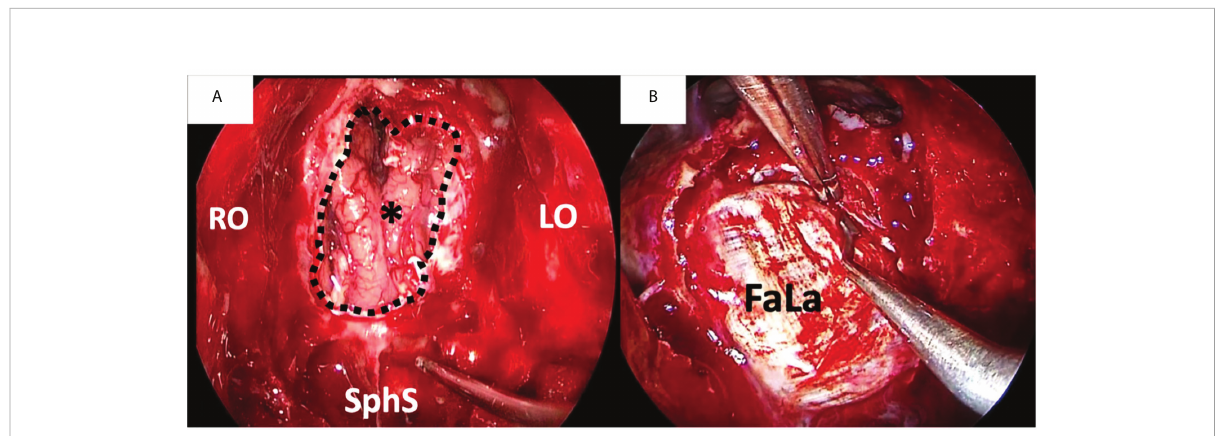
FIGURE 1 Duraplasty with fascia lata (FaLa) after endoscopic transnasal craniectomy for an intestinal type adenocarcinoma. (A) Endoscopic view of the surgical fi eld after tumor removal: the right and left orbital walls (RO and LO, respectively), the sphenoid sinus (SphS) and the frontal lobe (asterisk) are exposed; the dotted line marks the limits of dural resection. (B) The fi rst layer of fascia lata is placed intradurally to obtain watertight